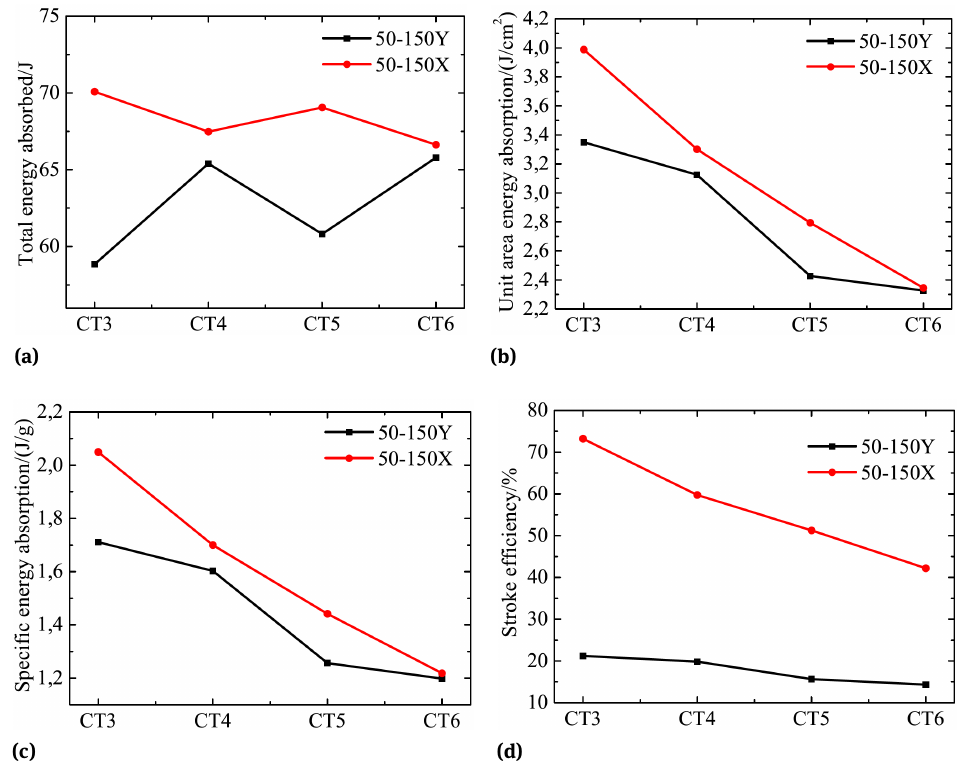
Figure 5: Cushioning energy absorption of different tube directions: (a) total energy absorbed, (b) unit area energy absorption, (c) specific energy absorption and (d) stroke